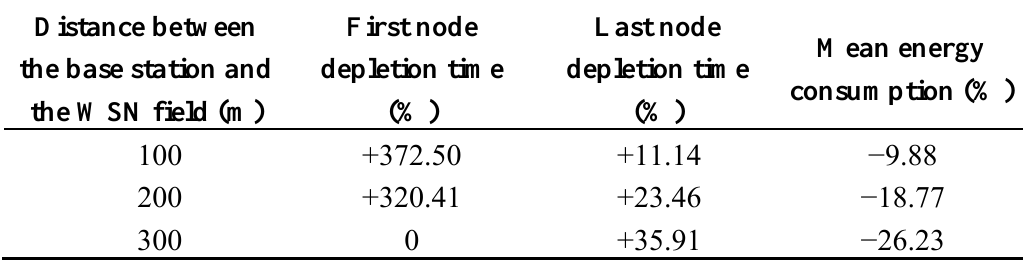
Table 3. Percentage of change in WSN performance by the use of SHPER opposed to TEEN over the distance of the base station from the sensor field when the initial node energy ranges from 0.1 to 0.5